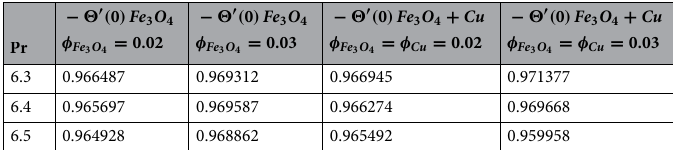
Table 6. Exhibits the Numerical outcomes of Nusselt number − � ′ ( 0 ) at the disc surface. When Re ω = 0.3, = Re (cid:31)